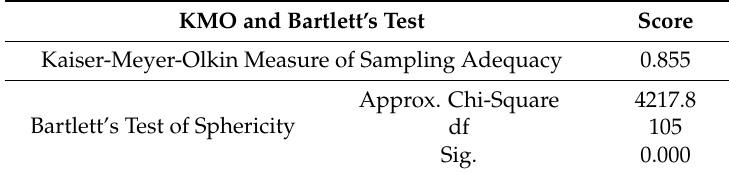
Table 2. Kaiser–Meyer–Olkin (KMO) and bartlett’s test of sphericity.